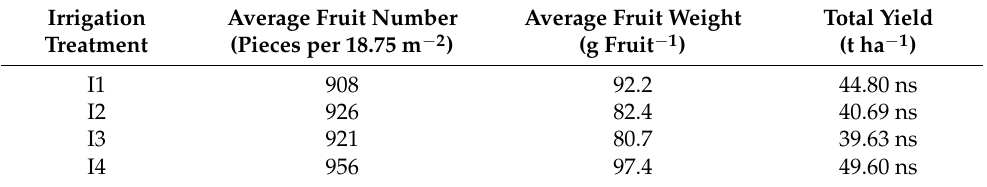
Table 5. Fruit number, fruit weight and total yield of tomato cultivated under different